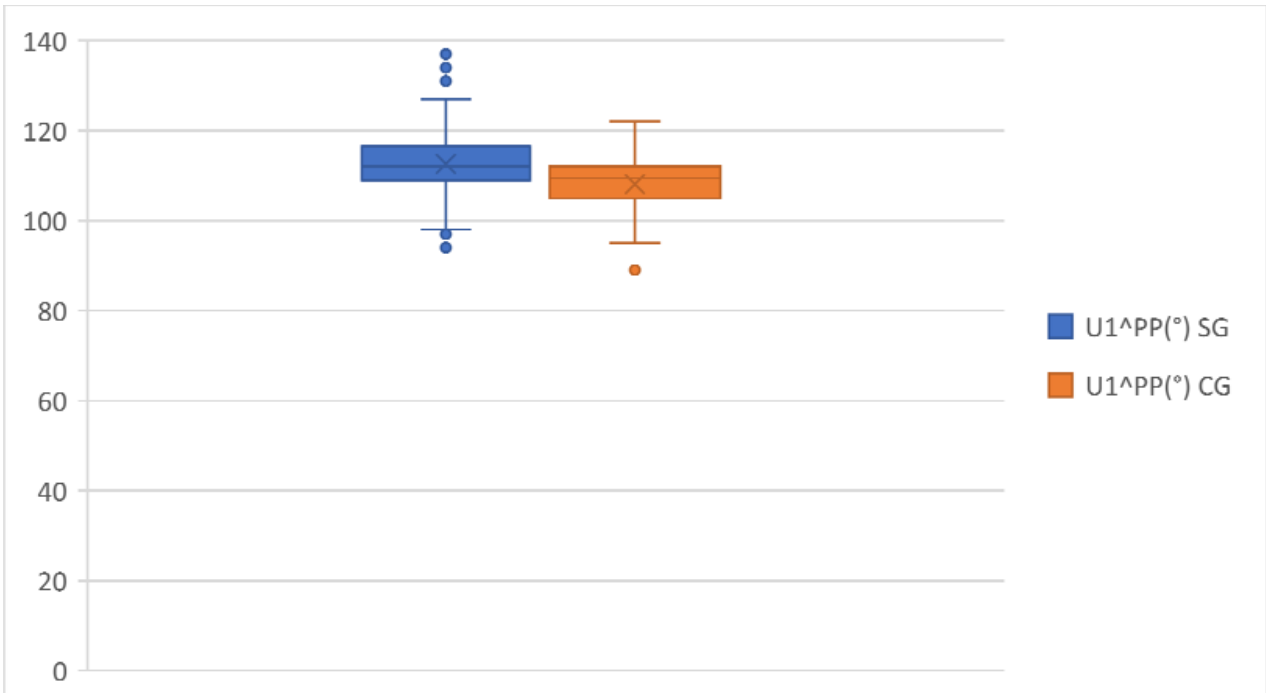
Figure 3. U1^PP comparison in the study group and the control group. Figure 3. U1ˆPP comparison in the study group and the control group. The mean of SNˆPP and FMA, used in this study to indicate skeletal divergence, showed values within the normal range in both